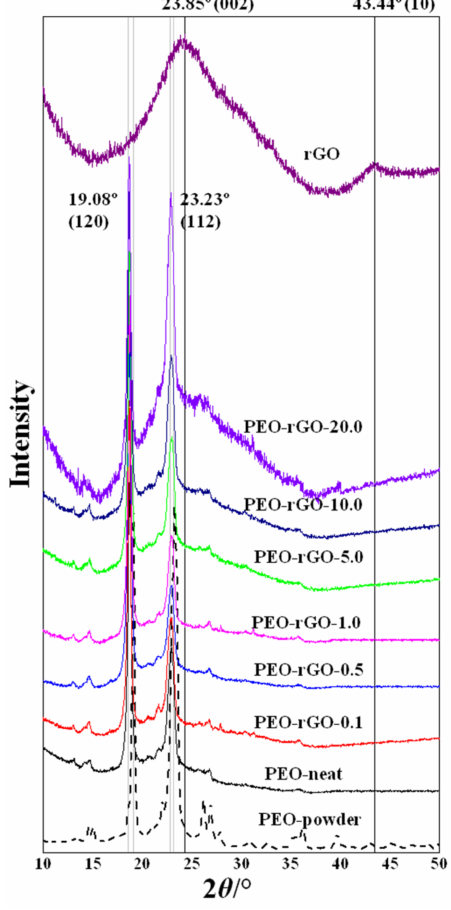
Figure 4. XRD patterns of rGO, PEO-powder, electrospun PEO-neat and electrospun PEO-based samples modified with